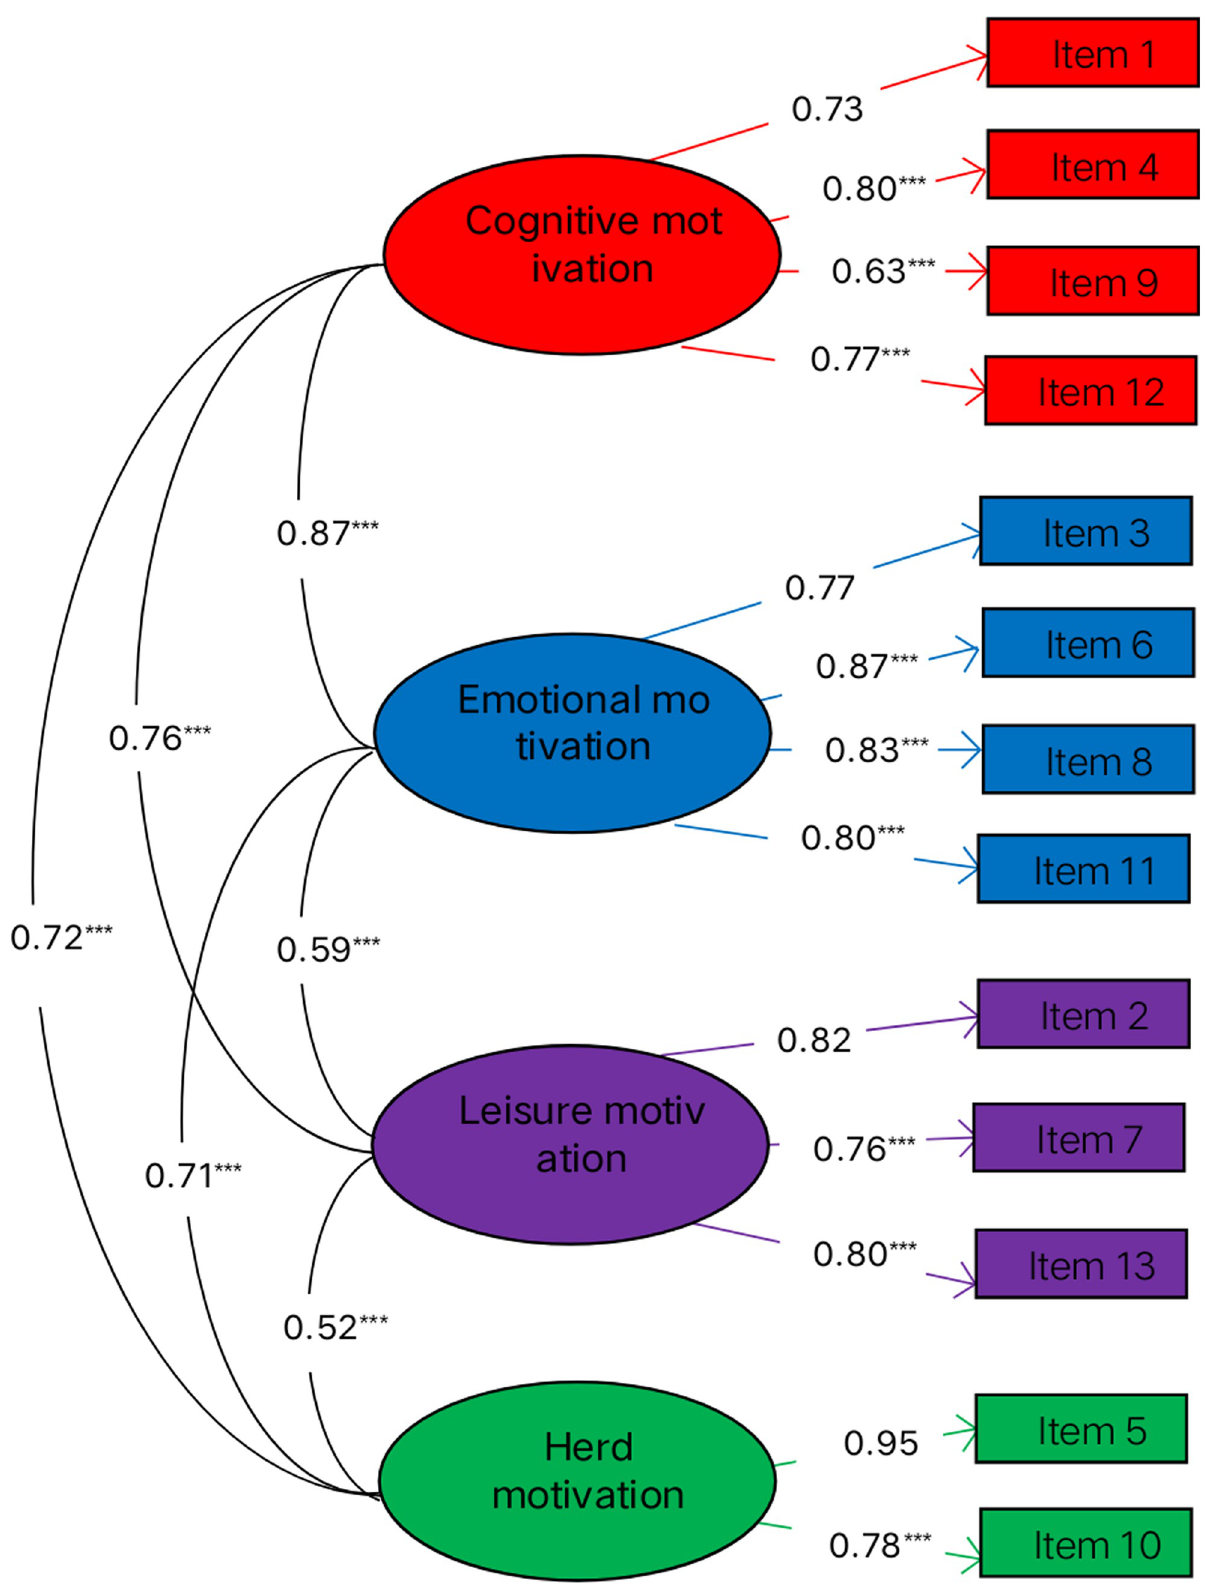
Fig 3. Confirmatory factor analysis of the four-factor SNSU MMG. � p < 0.05; �� p < 0.01; ��� p < 0.001, the same below.